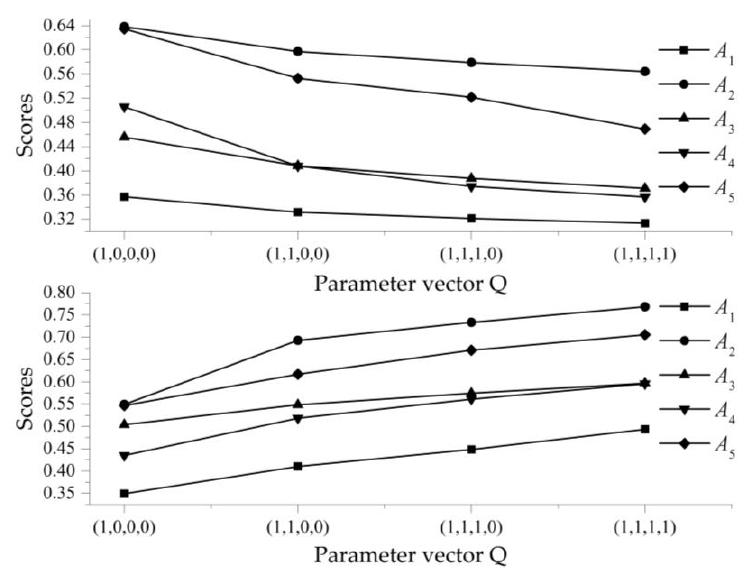
Figure 2. Scores of alternatives for interrelationship of different arguments.